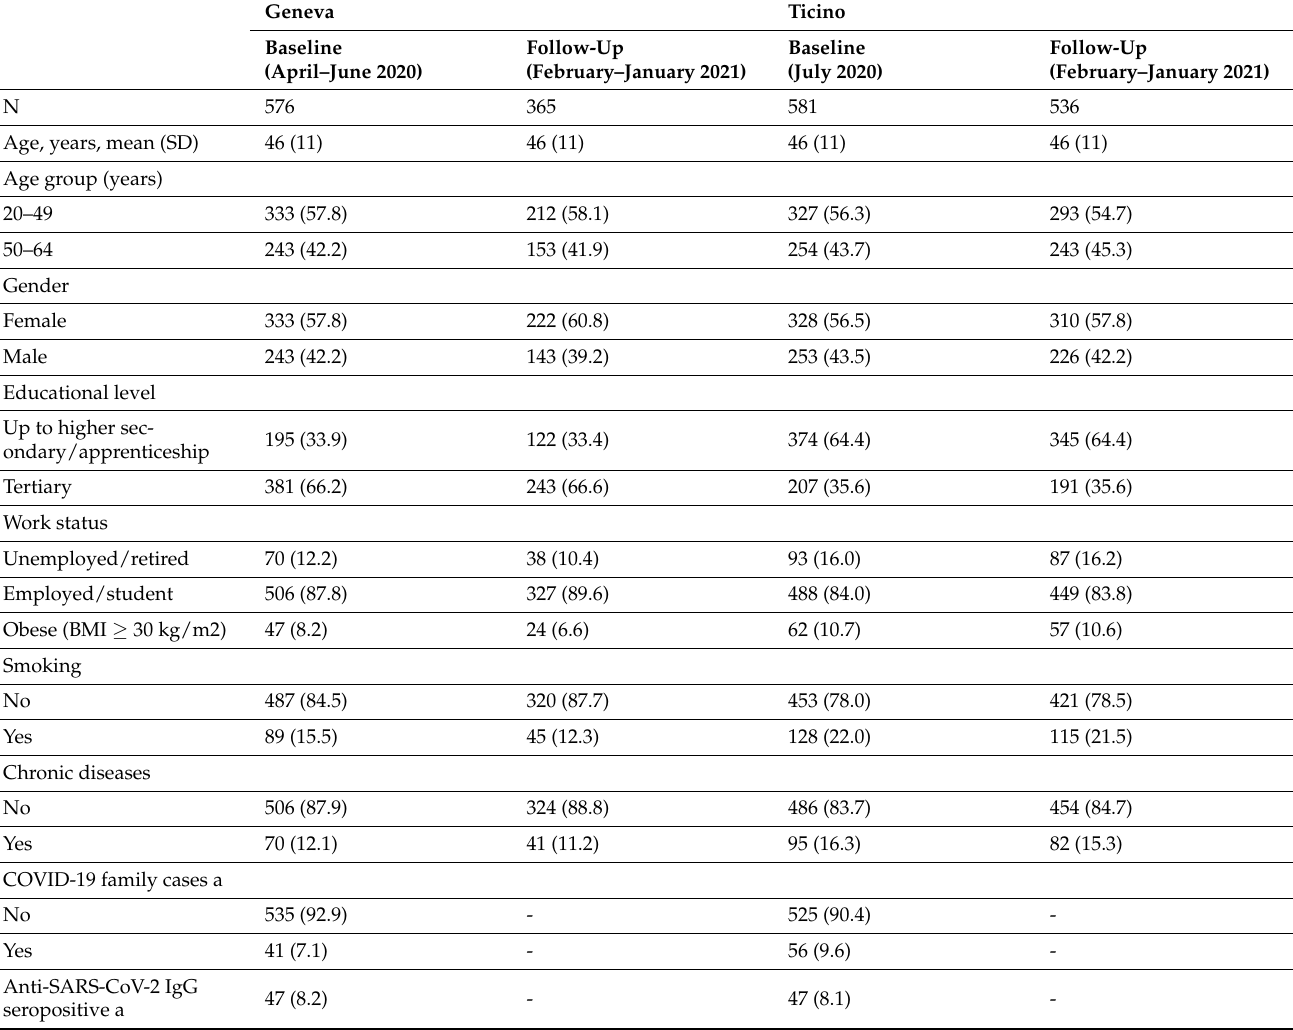
Table 1. Description of samples by study sites and